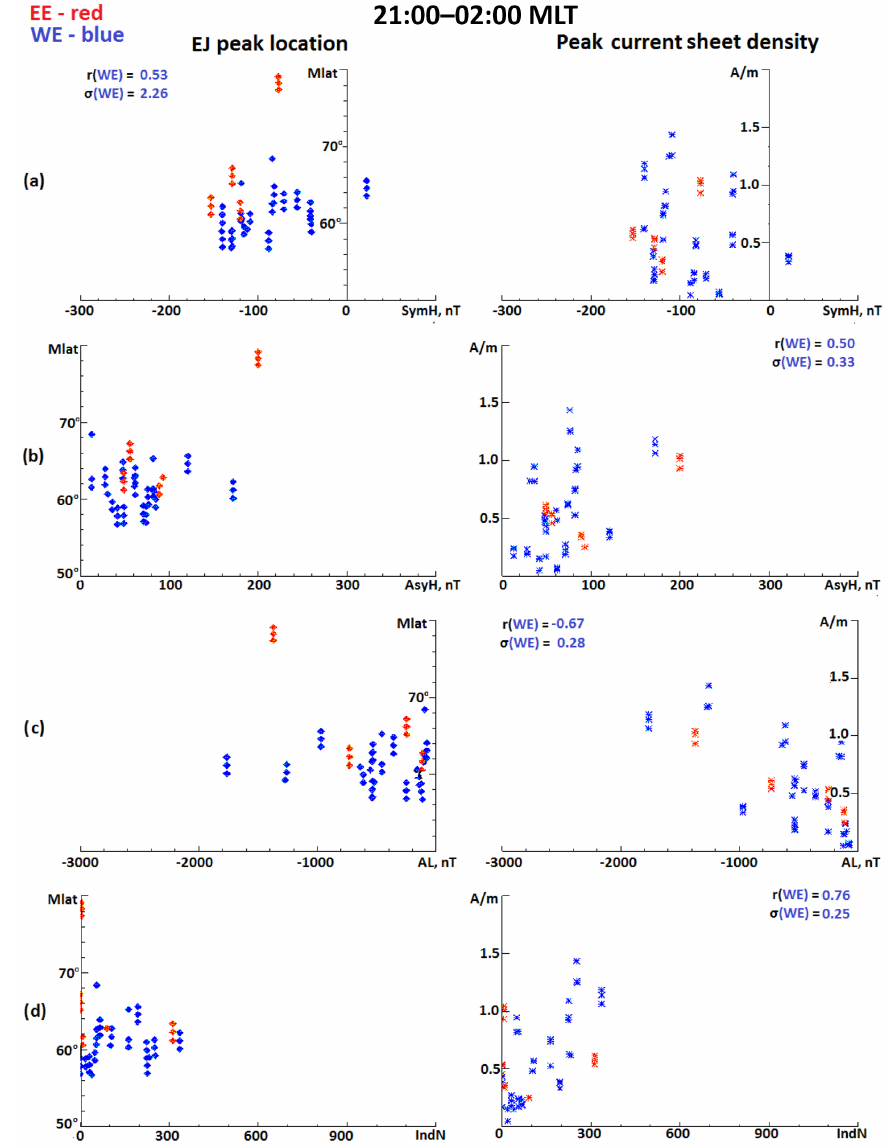
Figure 6. The same as in Fig. 4, but for the midnight sector (21:00–02:00MLT).